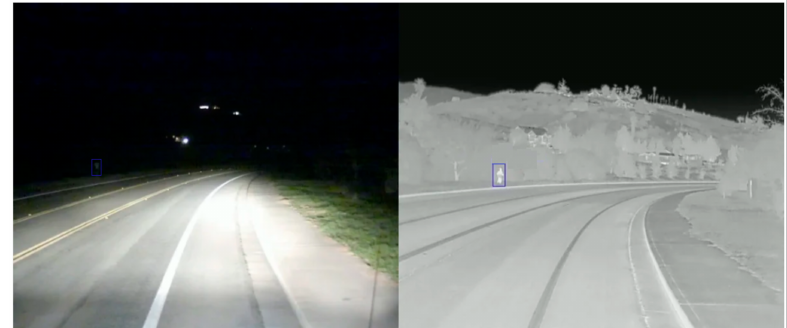
Figure 1. RGB image ( left ) and TIR image ( right ) under low illumination.